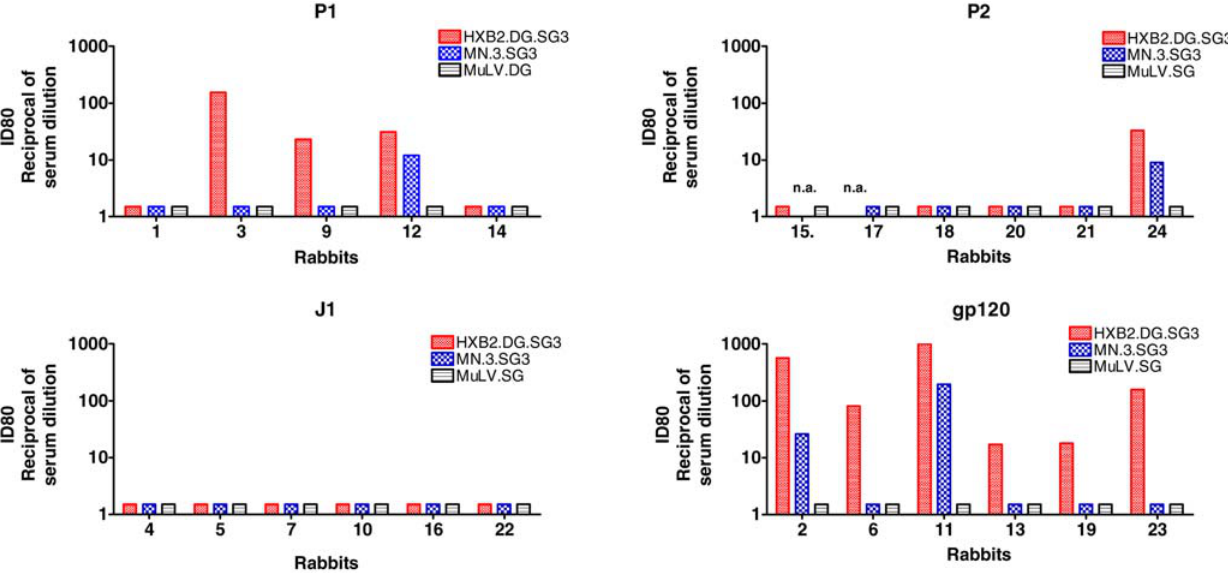
Figure 3. Evaluation of P1 and P2-induced neutralizing activity in an Env-based pseudovirus assay. Data are reported as reciprocal of serum dilutions giving 80% of pseudovirus neutralization (ID80). Neutralization data on Murine Leukemia Virus (MuLV) are also reported as control. For sample shortage due to technical problems it was not possible to perform the assay with sera from rabbit # 8 (P1 group), and for rabbits # 15 and # 17 (P2 group) on MN and HXB2 pseudoviruses, respectively.